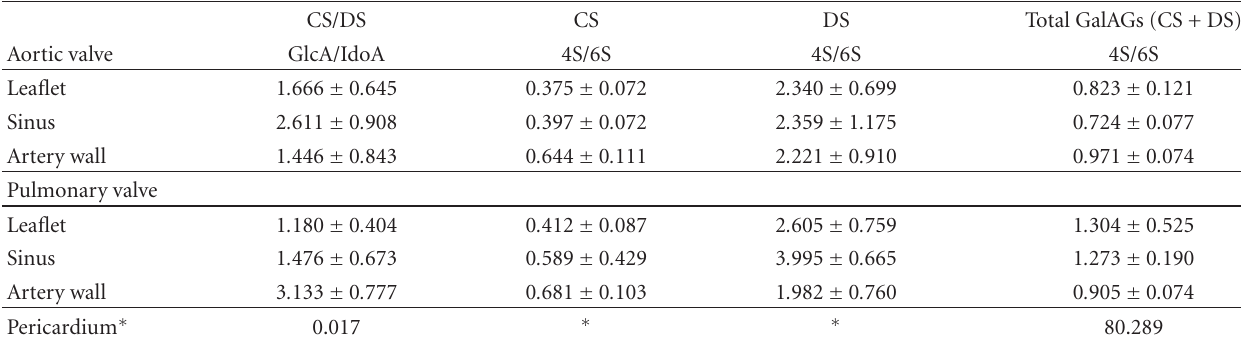
Table 3: Levels of epimerization and sulfation of CS isomers (means ± SD).